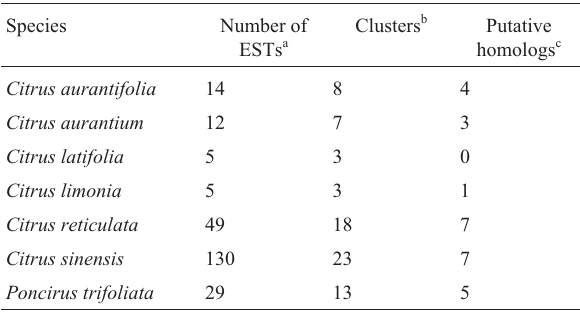
Table 2 - Citrus putative homologs to the CONSTANS -like genes of Arabidopsis . Species Number of